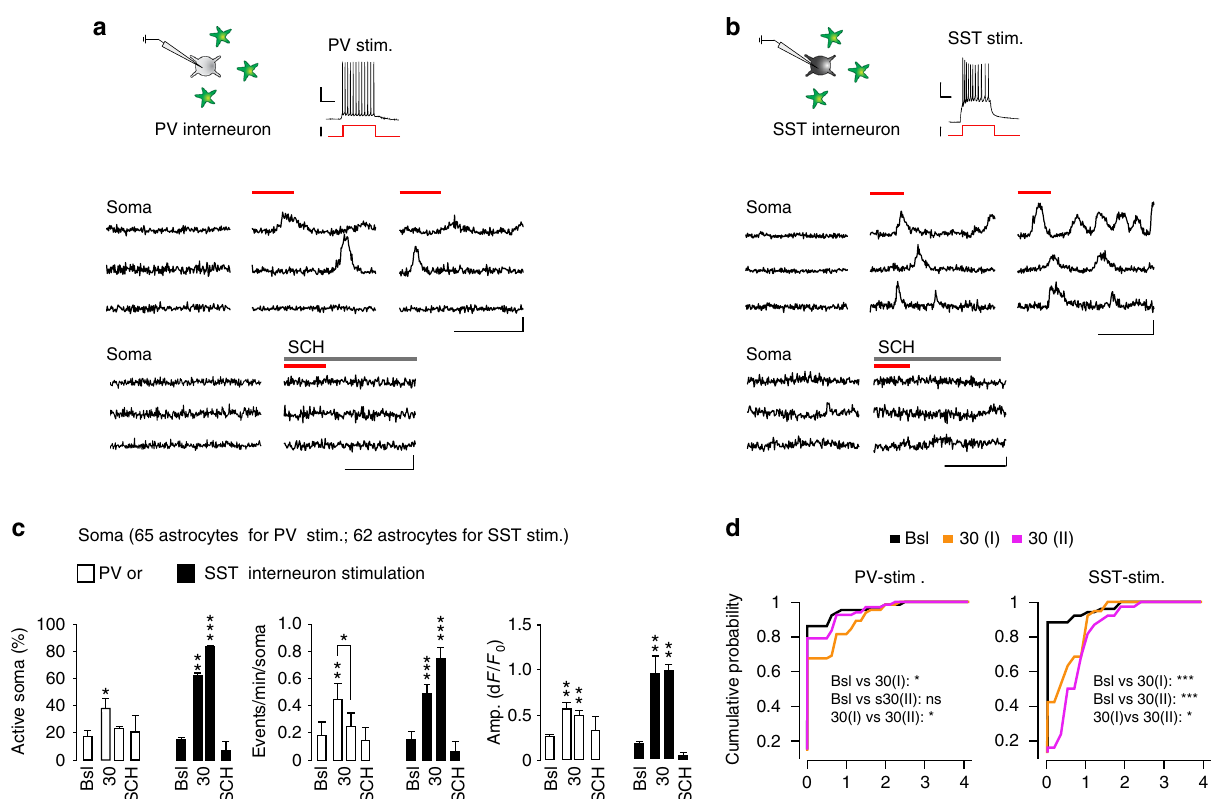
Fig. 4 GABAergic signaling from individual PV or SST interneurons in SSCx slices is suf fi cient to recruit neighboring astrocytes. a , b Top, schematics of patch-clamp experiments and representative AP fi ring induced by intracellular depolarizing current pulse injections into a PV (mean fi ring rate, 11.8 ± 2.1 Hz) or a SST interneuron (mean fi ring rate 9.0 ± 1.44 Hz; burst fi ring rate, 30 ± 4.8 Hz). Scale bars, 100 ms, 20 mV, 200 pA. Bottom: somatic Ca 2+ signal dynamics from representative astrocytes before and after two sequences of 30 current pulses (red lines) delivered to PV or SST interneurons in absence or presence of SCH50911 (SCH, 50 µ M). Astrocytes from an area within 100 μ m from the patched interneuron were considered. Scale bars, 50 s, 20% d F / F 0 . c Mean percentage of responsive astrocytes and mean Ca 2+ oscillation frequency in response to individual PV (65 astrocytes, 4 slices, 4 mice) or SST interneuron (62 astrocytes, 4 slices, 4 mice) stimulation. Data are represented as mean ± SEM. d Cumulative distributions of Ca 2+ event frequency after two subsequent 30 current pulse injections. With respect to the fi rst stimulation, the astrocyte response to the second PV interneuron stimulation was signi fi cantly depressed, whereas that to the second SST interneuron stimulation was signi fi cantly potentiated (Kolmogorov – Smirnov test, * p ≤ 0.05, ** p ≤ 0.01, *** p ≤